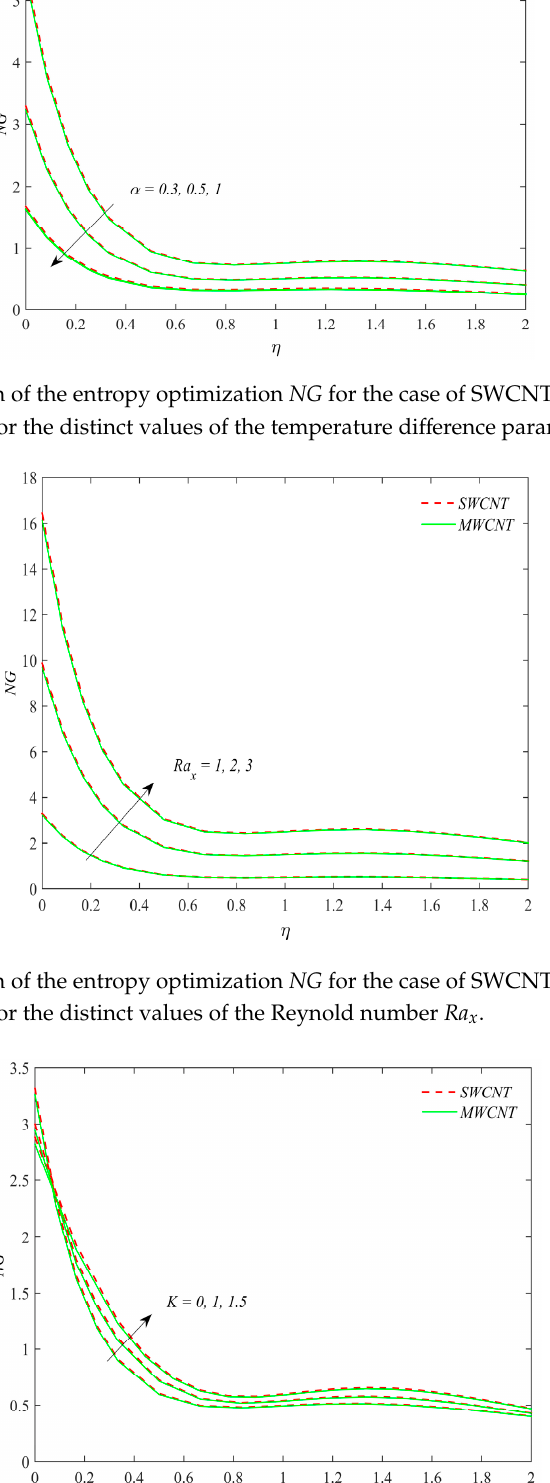
Figure 24. The variation of the entropy optimization NG for the case of SWCNT and MWCNT versus the similarity variable for the distinct values of the material parameter K .